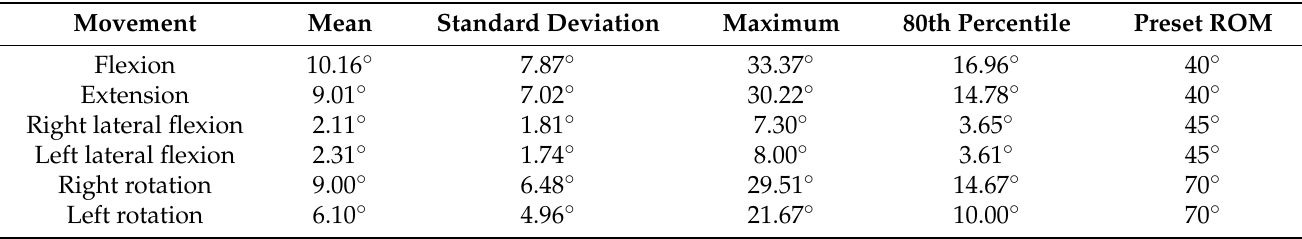
Table 5. ROM results of Profile 3 (After outliers’ filtering, the analyzed data for the Profile 3 supposed a 98% of the total flexion-extension raw data, a 93% of the total lateral flexion raw data, and a 99% of the total rotation raw